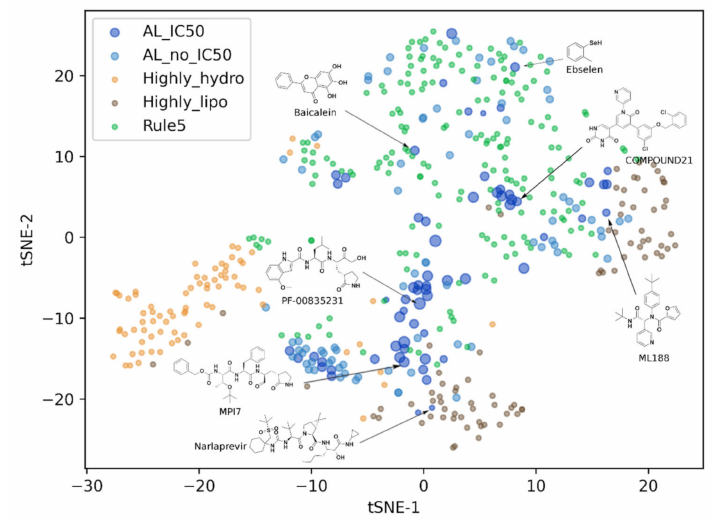
Figure 4. The t-distributed stochastic neighbor embedding (tSNE) map of the chemical spatial features including cLogP (calculated lipophilicity), HBA (hydrogen-bond acceptor), HBD (hydrogen- bond donor) and MW (molecular weight) for each CADD recommended compounds and the co- crystallized inhibitors against Mpro. AL_IC50 represents the inhibitors with known IC50. The size of the circles refers to the IC50 of the compounds (the larger size indicates the smaller IC50). AL_no_IC50 represents the inhibitors with unknown activity data; Rule5 represents the CADD compounds that meet the criteria of MW ≤ 600, HBA ≤ 10, HBD ≤ 5, and − 2 ≤ cLogP ≤ 5; Highly_lipo refers to the CADD recommended compounds that violate one or more of the above criteria and cLogp > 2 (i.e., compounds with high lipophilicity); Highly_hydro refers to the CADD recommended compounds that violate one or more of the above criteria and cLogp < 2 (i.e., compounds with high